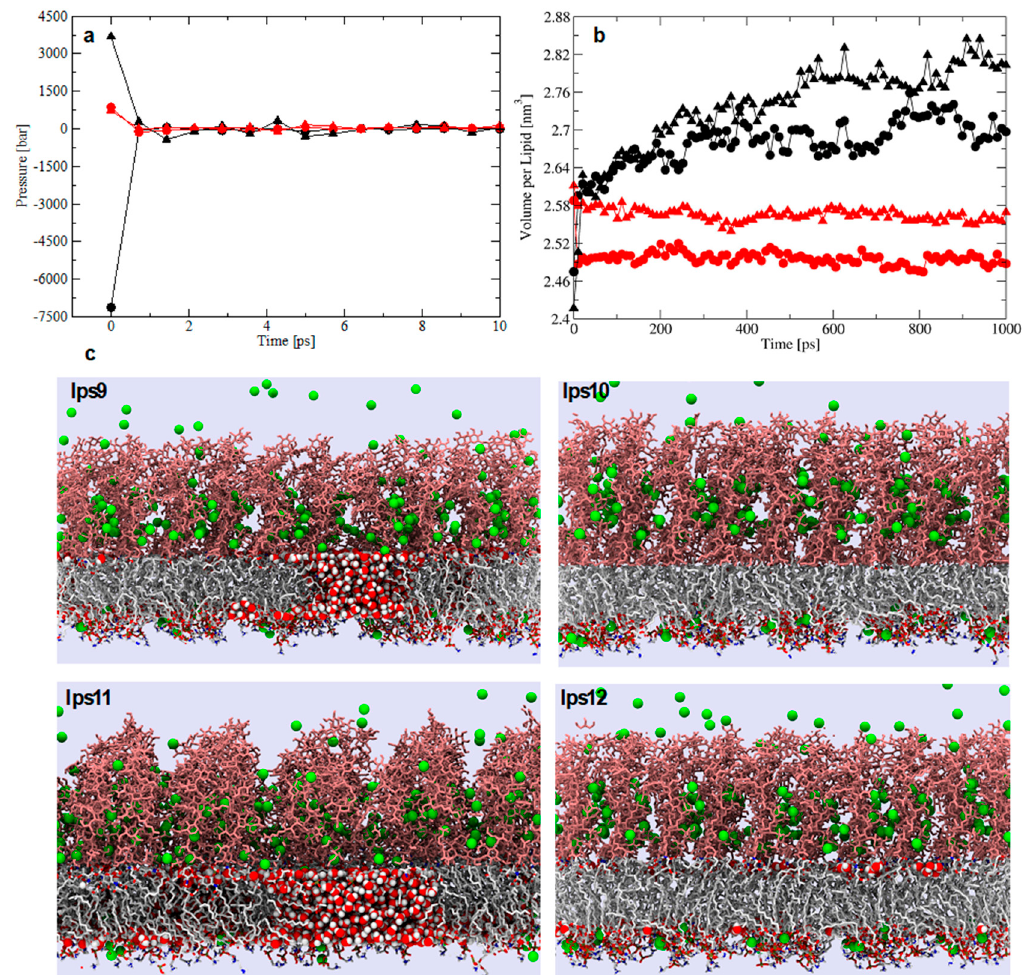
The e ff ect of the equilibration protocols (NPT-only and stepwise thermalization NVT / NPT protocols), barostat (Berendsen and Parrinello–Rahman), and thermostat (Berendsen and Nose–Hoover) on the ( a ) initial pressure and ( b ) molecular volume of LPS / DPPE bilayers. Symbols are NPT-only (black) and stepwise-thermalization NVT / NPT (red) protocols, Berendsen / Berendsen (circles), and Parrinello–Rahman / Nose–Hoover (triangles) barostats / thermostats, respectively. ( c ) Representative conformations from lipid-A simulations using the single-temperature NVT / NPT protocol. Systems are lps9 (black circle), lps10 (red circle), lps11 (black triangle), and lps12 (red triangle). Only water molecules inside the hydrophobic region of the membrane are shown and near clipping of LPS molecules was applied to improve visualization.